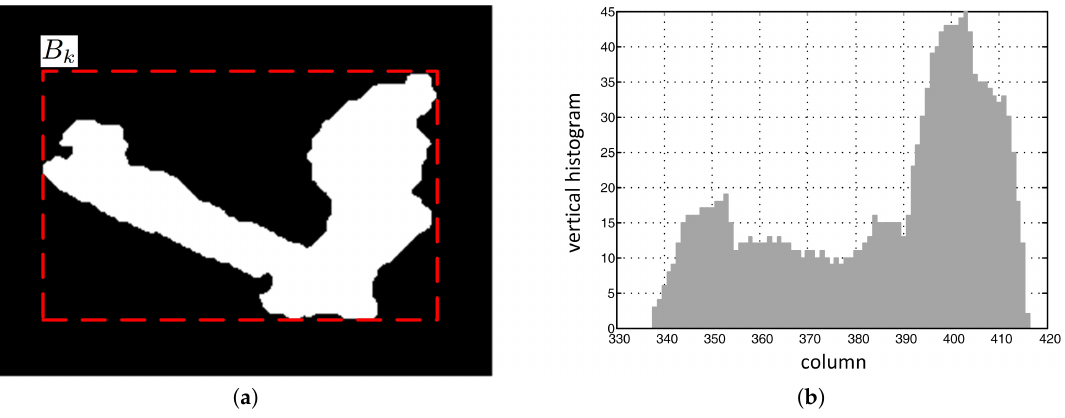
Figure 5. Vertical histogram of a foreground region: ( a ) A foreground region; ( b ) vertical